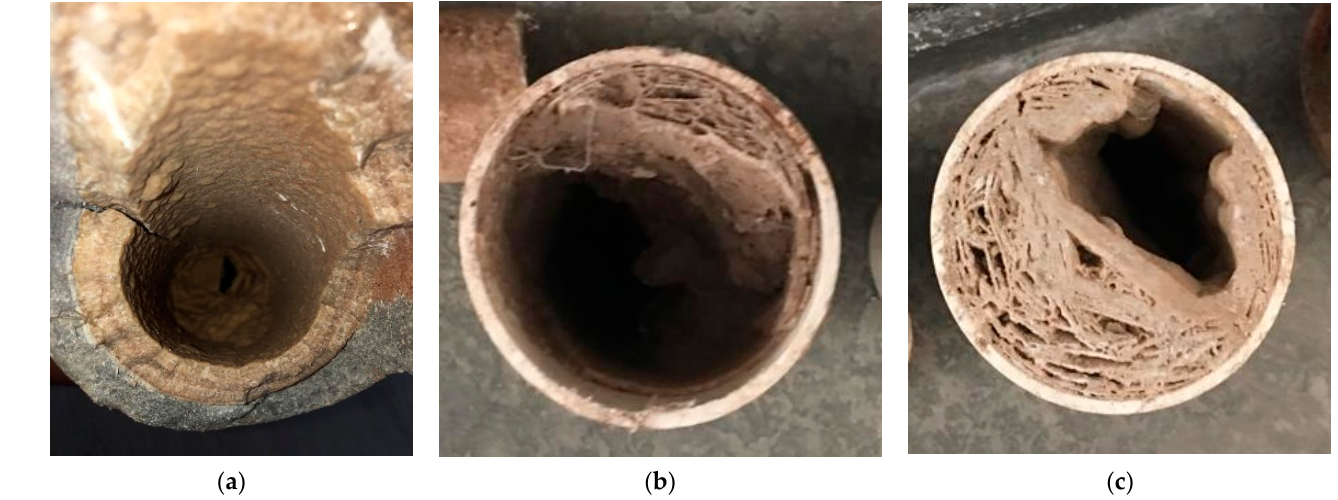
Figure 3. Asbestos ( a ) and PVC ( b , c ) sample pipes collected from different points along the Zacate- cas-México distribution network.